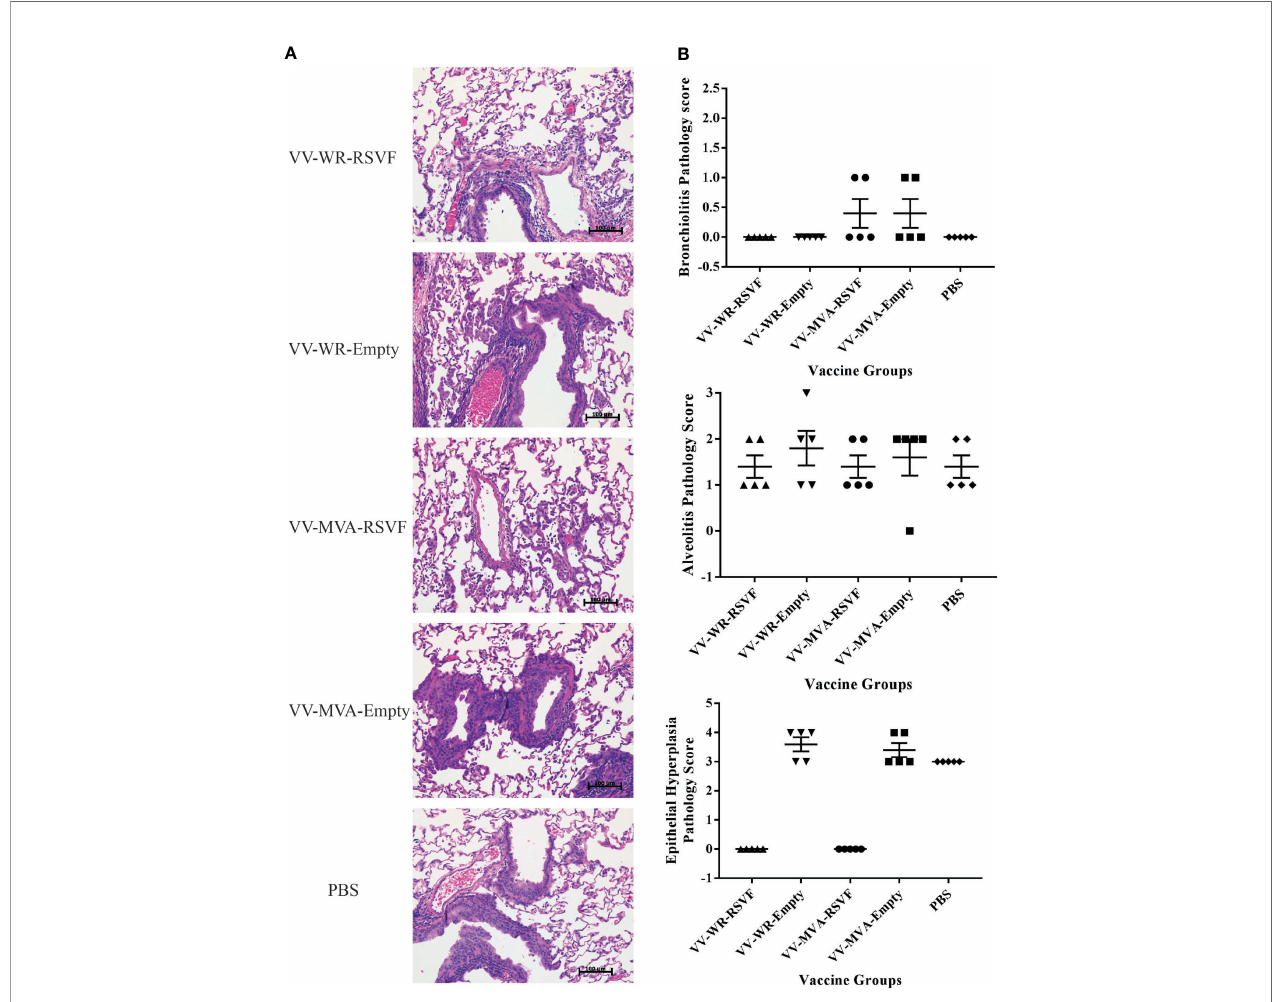
FIGURE 6 | Immunization with VV-WR-RSVF does not cause ERD in cotton rats. Cotton rats were intramuscularly immunized with one dose of 10 7 PFU of the indicated VV-WR or VV-MVA constructs and intranasally challenged with 10 6 PFU of RSV-A2 and necropsied 5 days later with n = 5 cotton rats per treatment group. The left lobe of the lung was evaluated for histopathological changes. (A) Representative images of H&E stained immunized cotton rat lungs post challenge at 40x magni fi cation. (B) Pathological scoring of lung tissue for bronchiolitis, alveolitis, and epithelial hyperplasia (n =